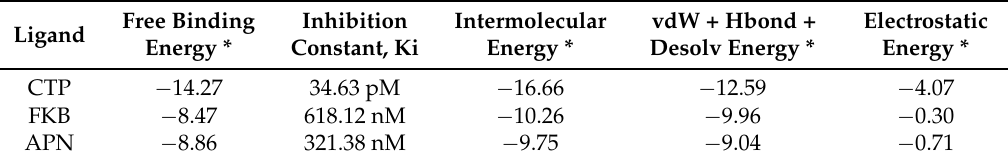
Table 1. The lowest energy docked conformation from each ligand.